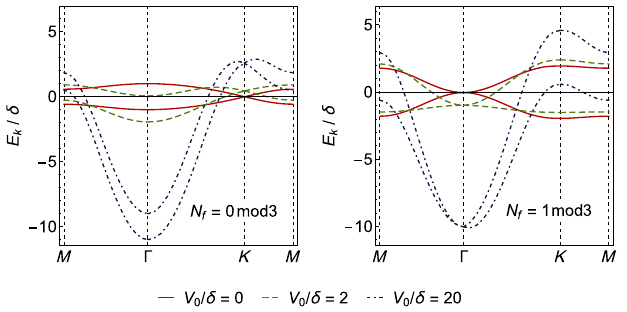
FIG. 9. Band structure for N f ¼ 0 mod 3 (left) and for N f ¼ 1 mod 3 (right) for V = δ ¼ 0 , 2, and 20, where V 0 0 is the strength of the periodic potential and δ the skyrmion-antiskyrmion tunneling rate. In our model system, we estimate that V 0 ≪ δ